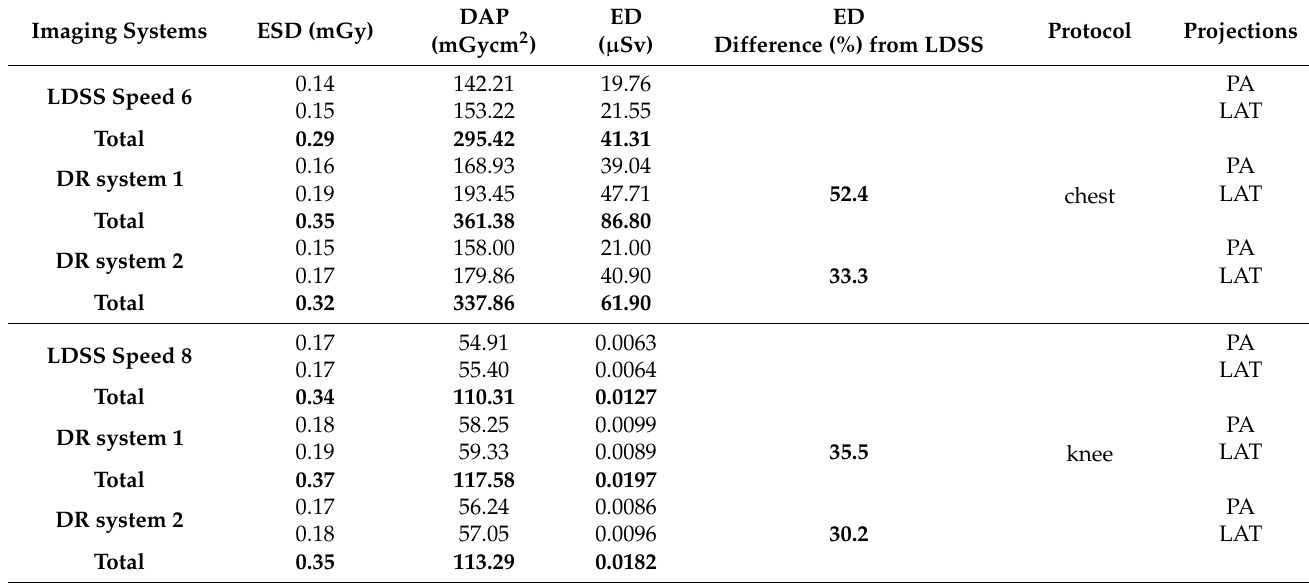
ED differences between the LDSS imaging system and DR imaging systems.